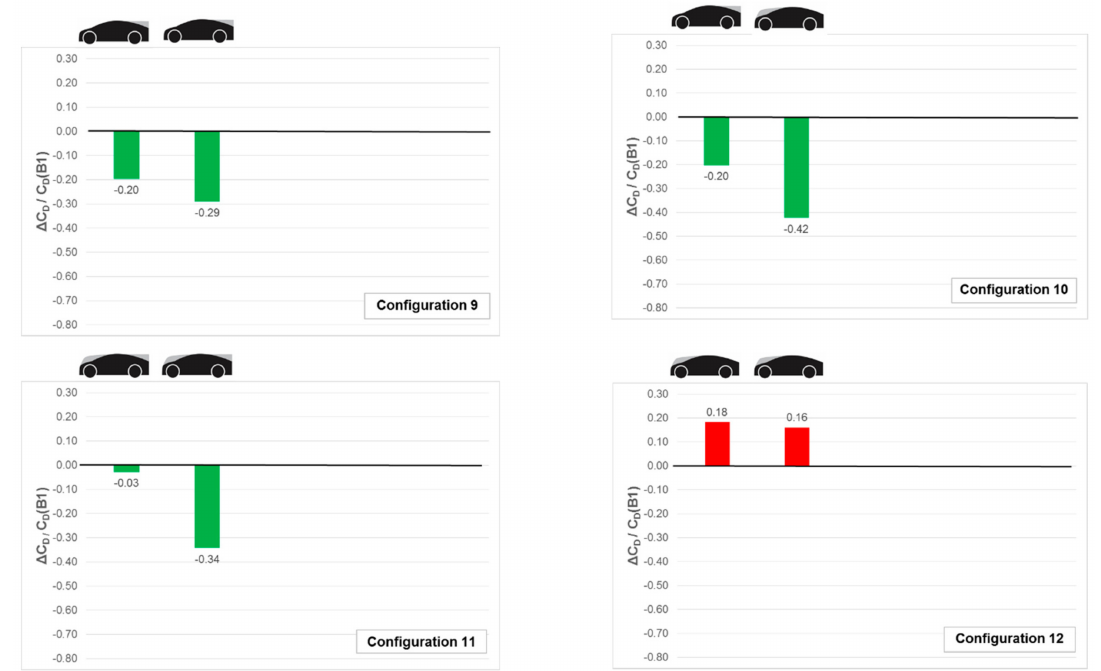
Figure 8. Change in Drag Coefficient ∆ CD between that of the baseline Resnick model (B1) and 2-vehicle platoons fitted with combinations of the add-on sections: Configuration 9 comprising two B2 versions of the model, Configuration 10 comprising a B2 version followed by a B4 version, Configuration 11 comprising two B3 versions, and Configuration 12 comprising two B4 versions.